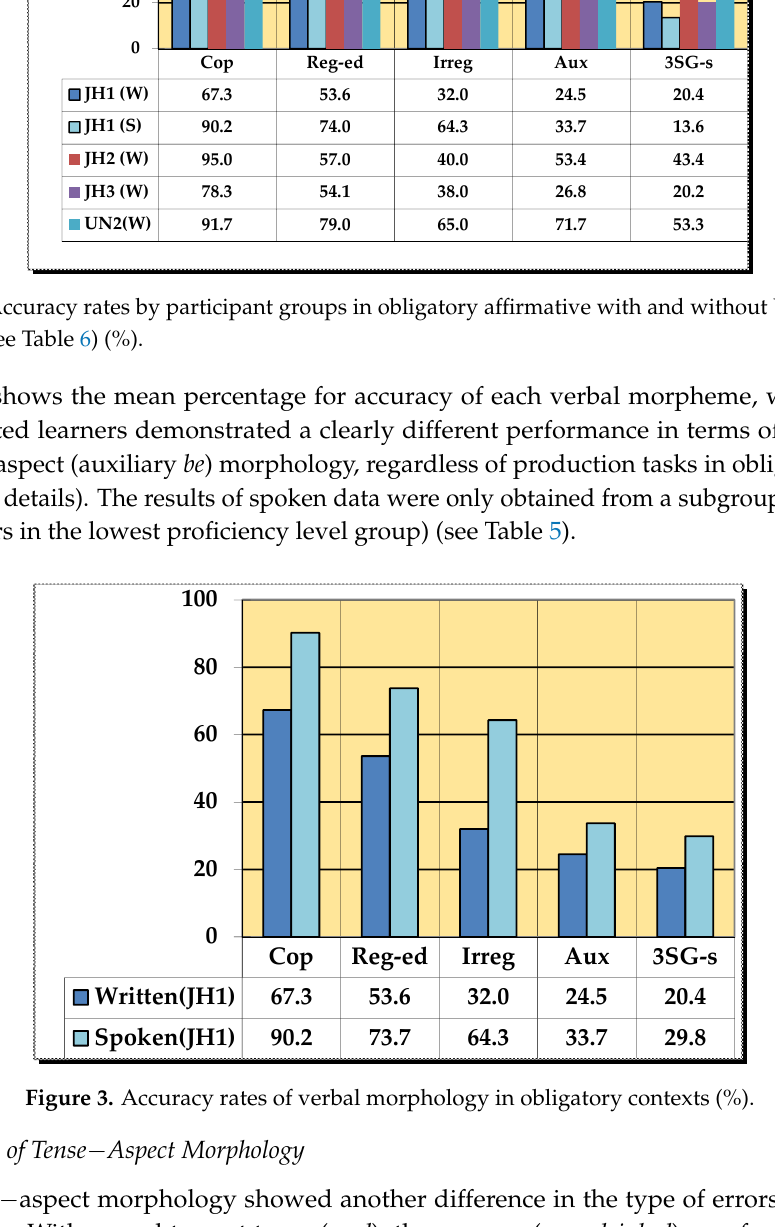
Figure 4. Overuse of regular past − ed in irregular past forms in obligatory affirmative with and without VP−adverb contexts (see Table 6) (%) . Figure 5 demonstrates a contrast in omission between − ed and − s . One−way ANOVA confirms a statistically significant difference between the two kinds of omission rates (written: F(1,28) = 55.90, p < 0.001; spoken: F(1,10) = 323.40, p < 0.001). This is similar to the results of a Yoshimura and Nakayama (2009)’s study which shows a significant difference between them ( p < 0.0014). The respective accuracy rates (Figure 2) inversely correspond to their omission rates.